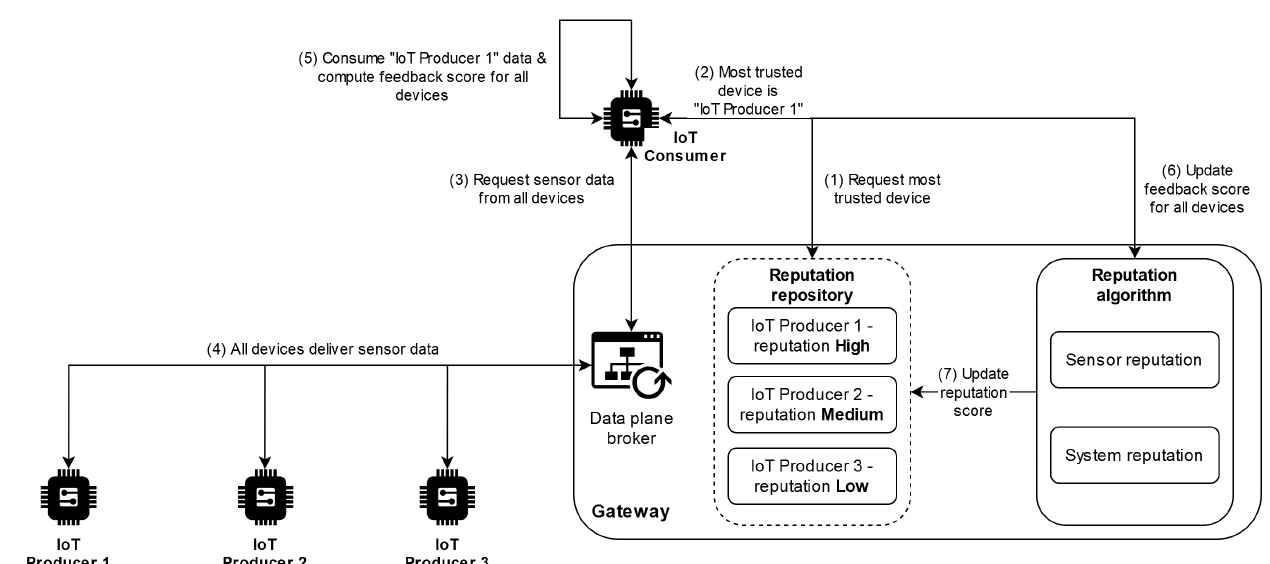
Figure 6. Reputation query and update